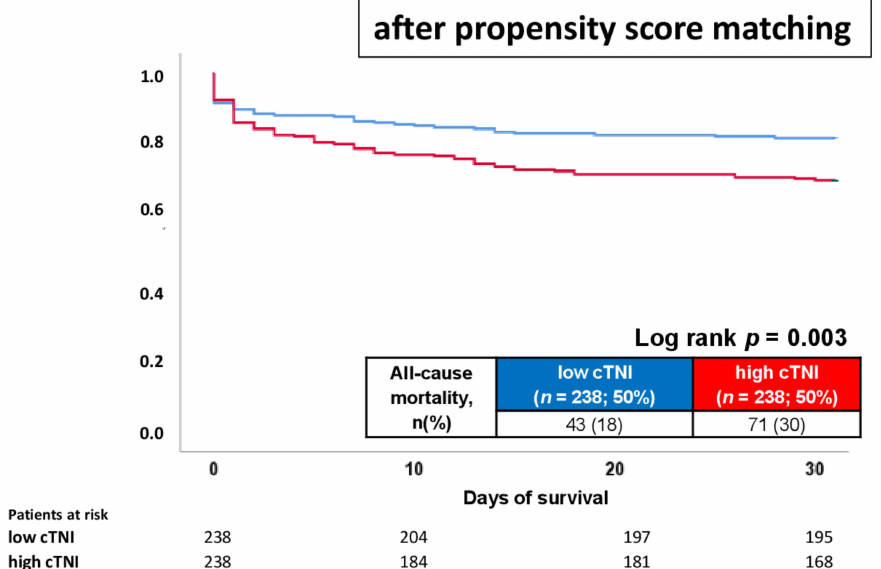
Figure 4. Kaplan–Meier analysis comparing patients with high cTNI to patients with low cTNI with regard to 30-day all-cause mortality (primary endpoint) within the propensity-matched